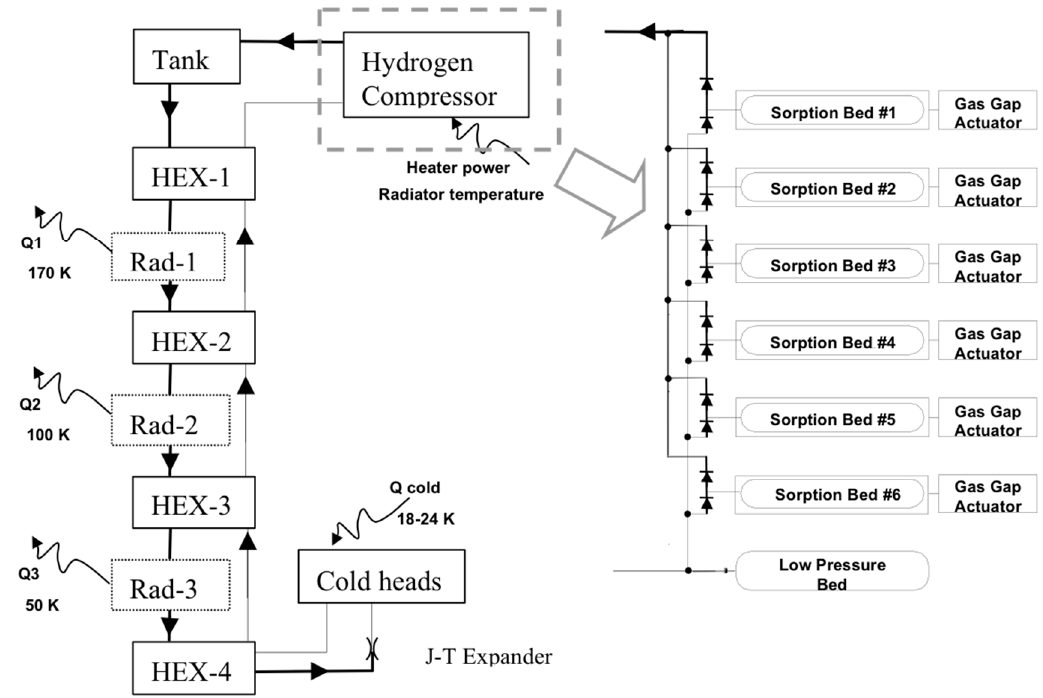
Figure 3. Planck sorption cryocooler schematic [16,17] (2019, with permission from Elsevier), with the three pre-cooling radiators (Rad-1,2,3), four heat exchangers (HEX-1,2,3,4), the Joule–Thomson (J–T) cold heads and the hydrogen compressor, which is expanded on the right side showing the six metal hydride sorption beds: The arrows in front of each sorption bed are check valves, allowing H 2 gas flow only in the arrow direction.